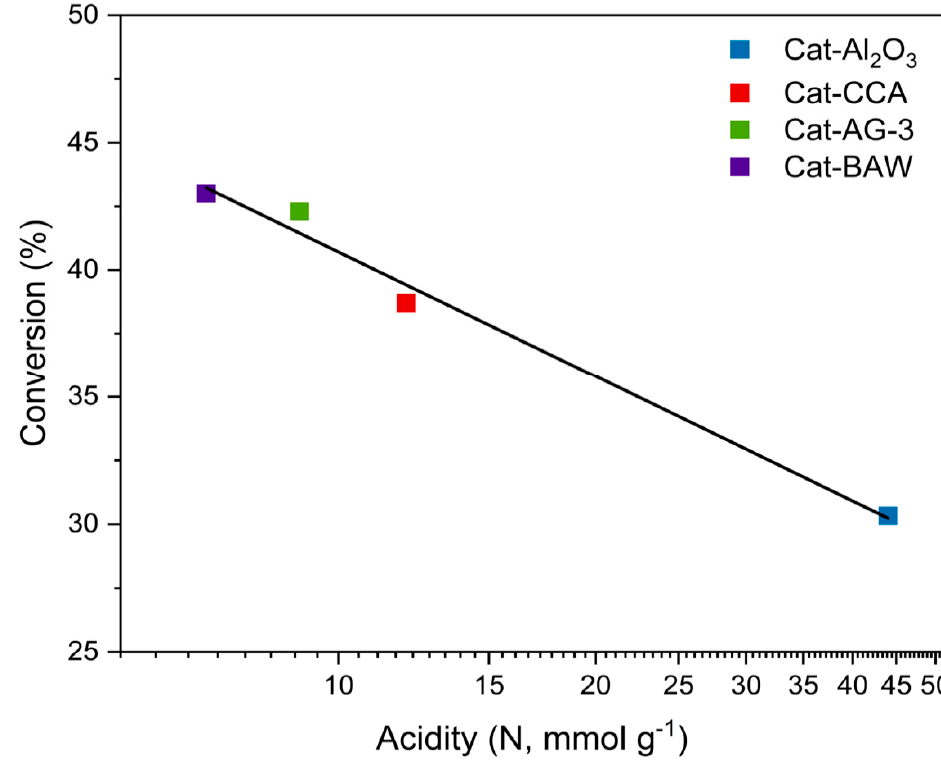
Figure 3. Inverse logarithmic relation between the conversion at 360 °C and the number of acid sites on the catalysts as determined from pyridine adsorption. Table 3. Comparison of literature reaction conditions, support nature, and catalytic activity in higher alcohol synthesis from synthesis based on supported K-modified CoMoS 2